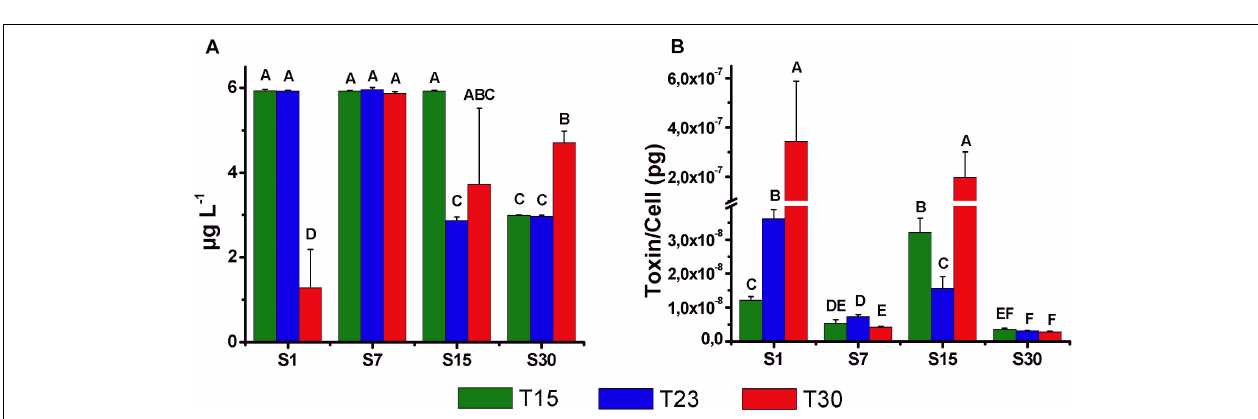
FIGURE 7 | Mean concentration of chlorophyll- a per cell (pg cell − 1 ) at the start, middle, and end of growth curves (A) , and (B) mean cell volume of the vegetative cells (VC) and akinetes (AK) of N. spumigena (NODSPU1) ( ± SD; n = 3). Significant difference is indicated by letter (ANOVA, Tukey’s p < 0.05). Lower case for VC and upper case for AK.